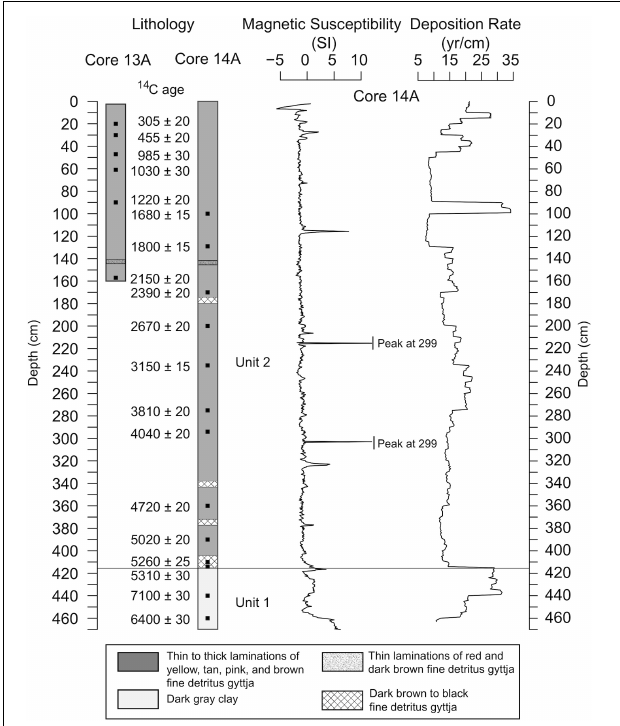
FIGURE 3 | Lithology, uncalibrated radiocarbon ages, magnetic susceptibility data, and deposition rate for the Black Lake sediment cores.